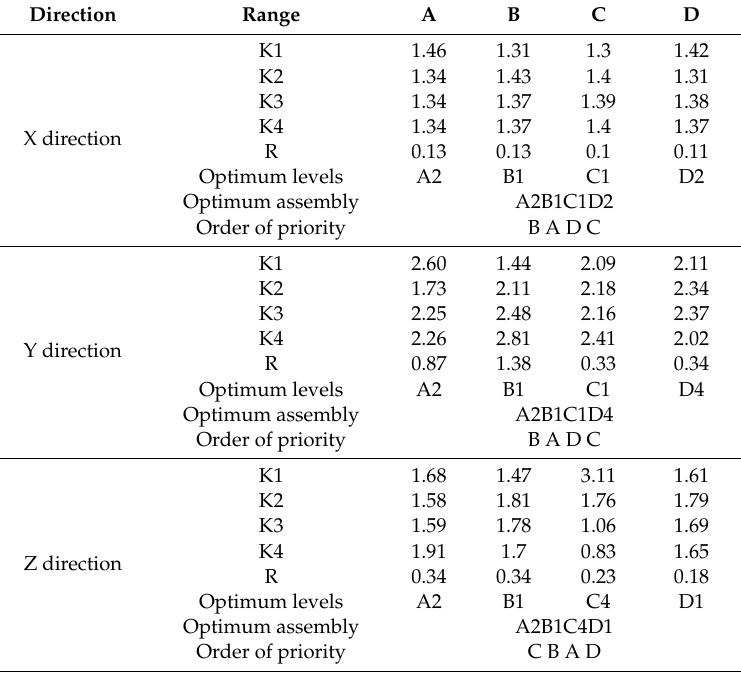
Table 6. Range analysis of dimensional